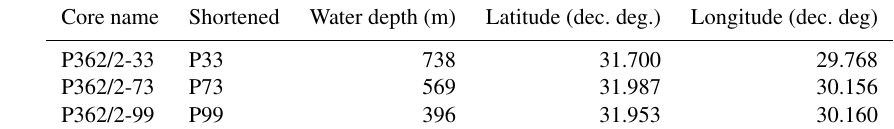
Table 1. Sediment cores used for the present study, with names used throughout the paper, water depths and coordinates.